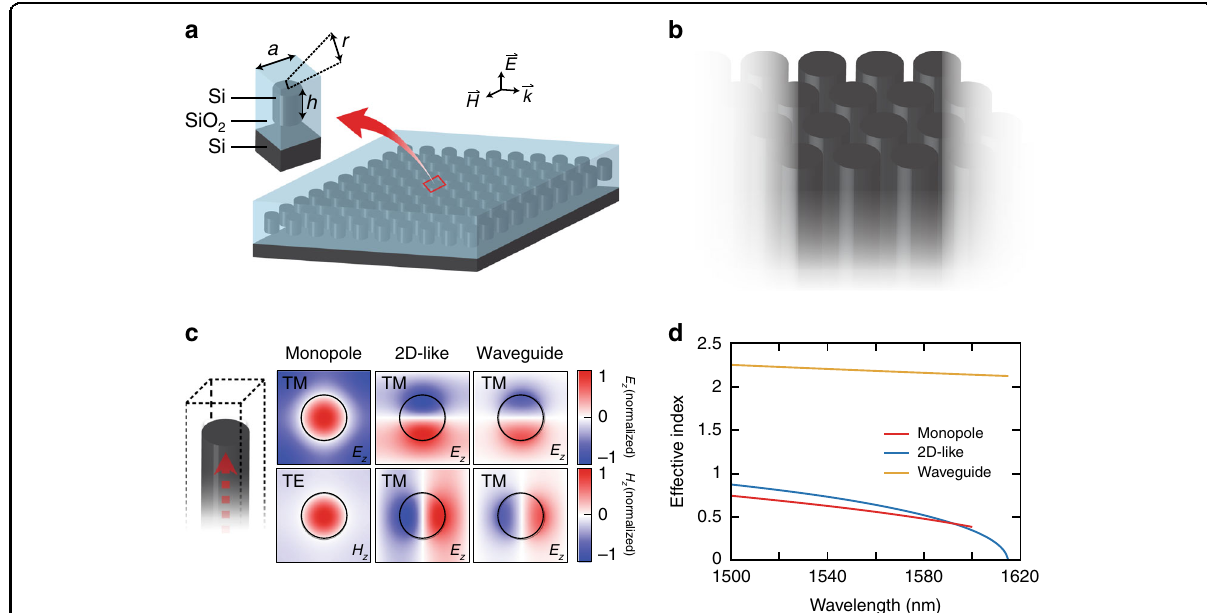
Fig. 2 Design of a BIC zero-index PhC slab and mode analysis. a Three-dimensional schematic of a zero-index PhC slab and its unit cell, consisting of silicon pillars embedded in silicon dioxide with radius r = 180 nm, pitch a = 733 nm and preliminary height h = 1000 nm. b 2D array of silicon pillars. c This array can support six supermodes propagating along the vertical direction: TM monopole, TE monopole, and two sets of TM dipoles. Here, we plot the electric fi eld polarized along the pillar axis for each mode, except for the TE monopole, whose axial magnetic fi eld is shown. d Each mode has an effective index, derived from the propagation constant, that varies as a function of the